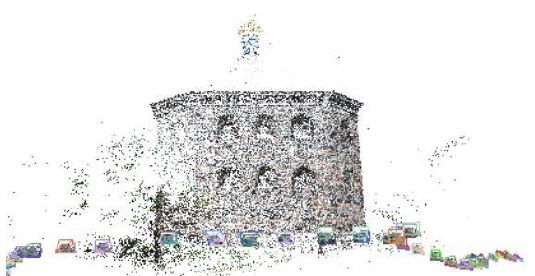
Figure 5 . Sprase point cloud and camera positions generated by multi-view images based on SfM.